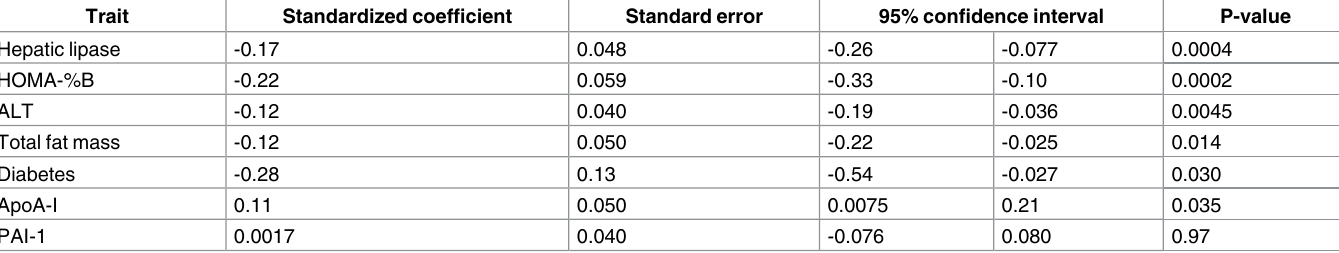
Table 3. Overall multivariate analysis.